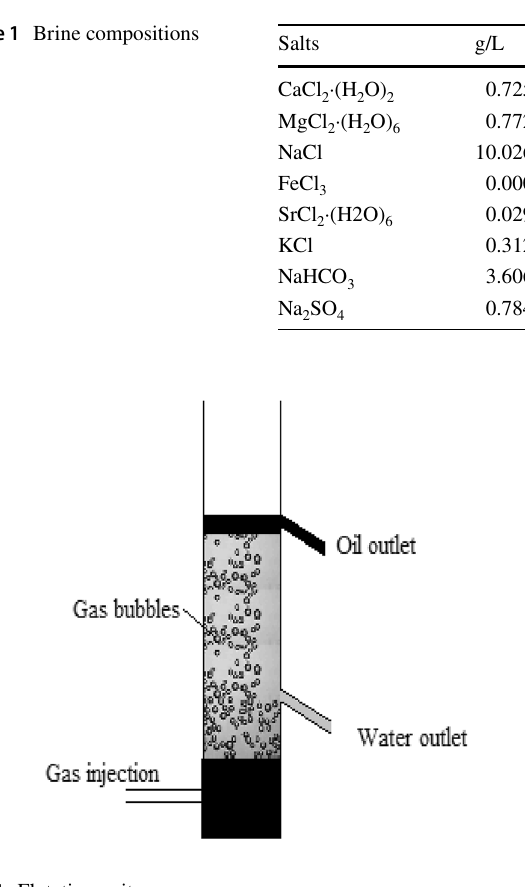
Fig. 1 Flotation